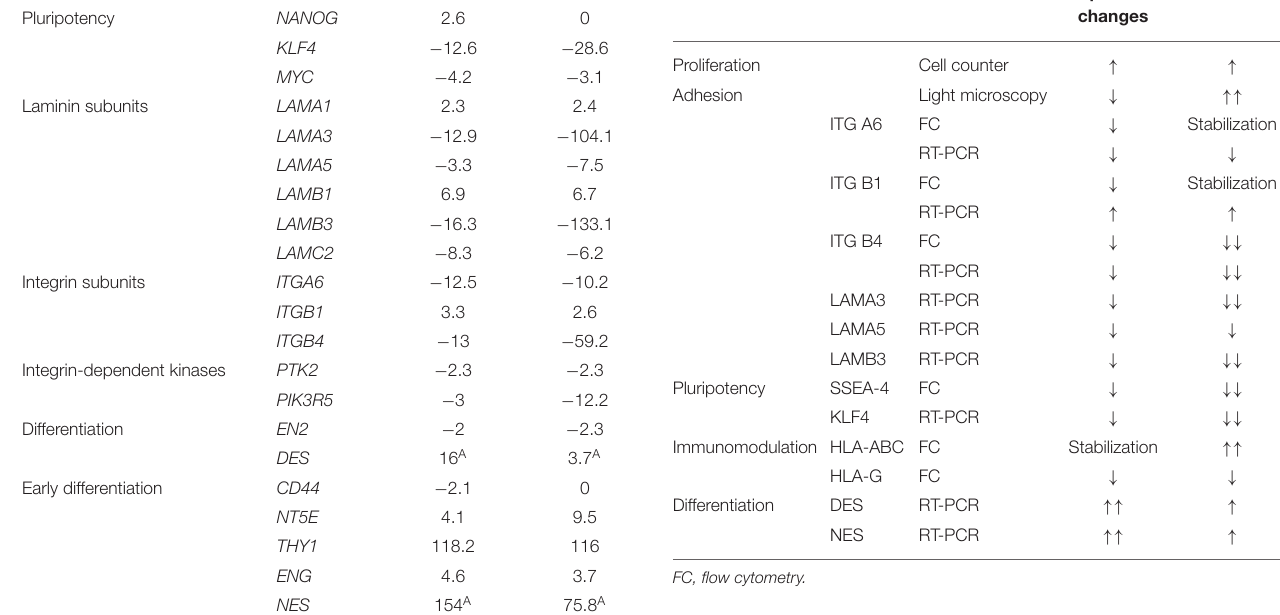
TABLE 4 | Gene expression fold-change after 14 days of culture on control and LN-332-coated plates comparing to 12h of culture. Gene function